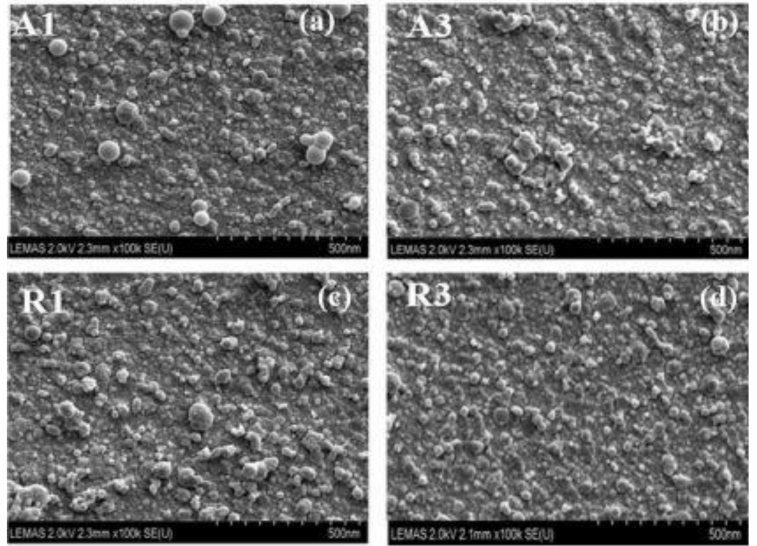
Figure 4. Surface morphologies of TiO 2 thin flms deposited onto glass substrate by fs-PLD at various substrate temperatures: ( a ) [A1 (25 ◦ C)], ( b ) [A3 (700 ◦ C)] and rutile thin flms: ( c ) [R1 (25 ◦ C)] ( d ) [R3 (700 ◦ C)]. Reprinted from reference [29] under license CC